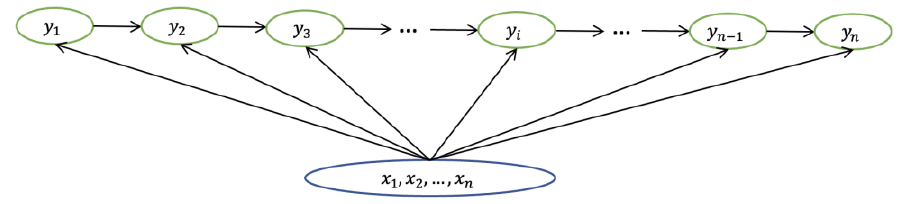
Figure 6. The structure of CRF model.